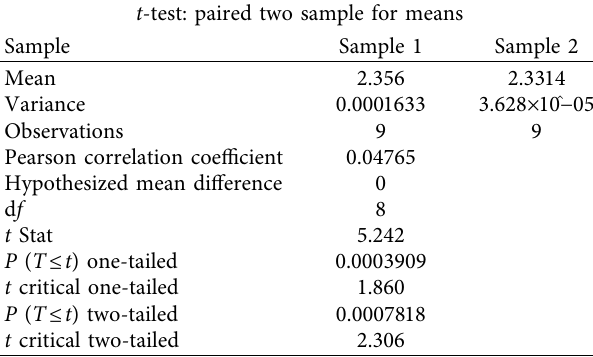
Table 9: t -test for the bulk specific densities of two types of core specimens.